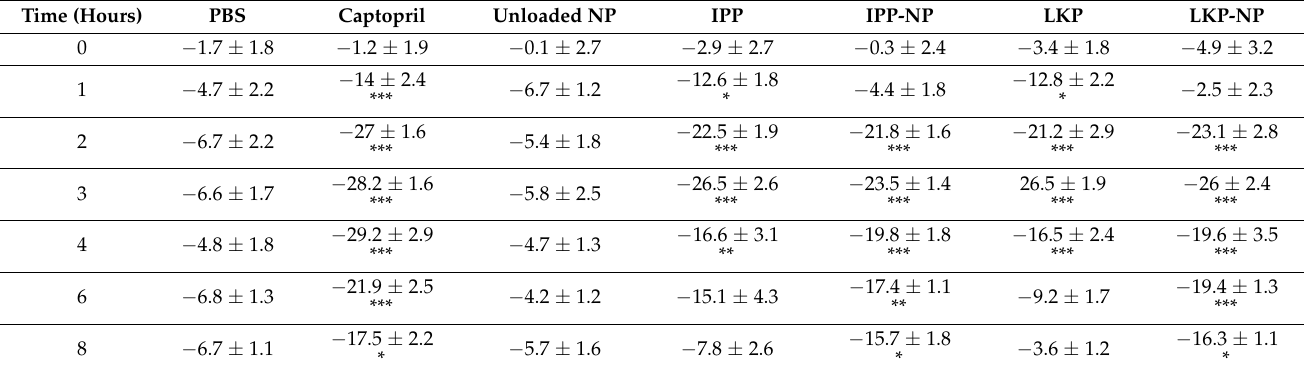
Table 5. Change in SBP of SHRs after single oral doses of various